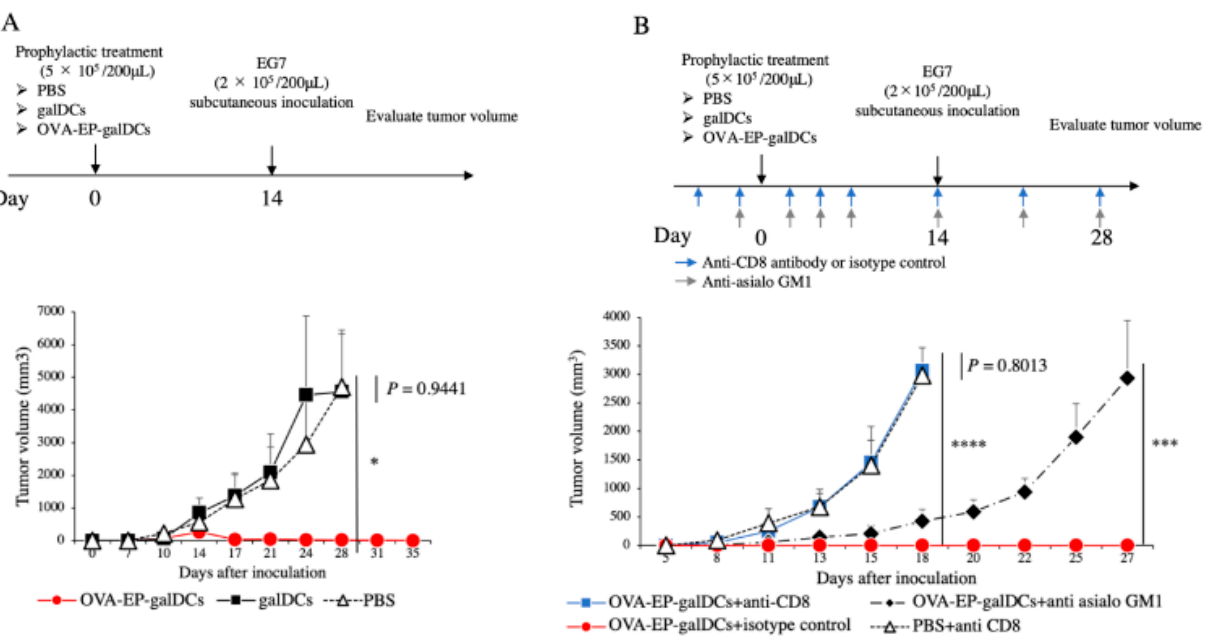
Figure 2. OVA-EP-galDC vaccine promoted complete rejection of subcutaneous tumors in a manner dependent on CD8 + T cells in prophylactic models. OVA-electroporated cells were sequentially in- cubated with α -GalCer and LPS, and adjusted as OVA-electroporated vaccine vectors (OVA-EP- galDCs). Similarly, galDCs without electroporation and PBS were prepared for the control. ( A )